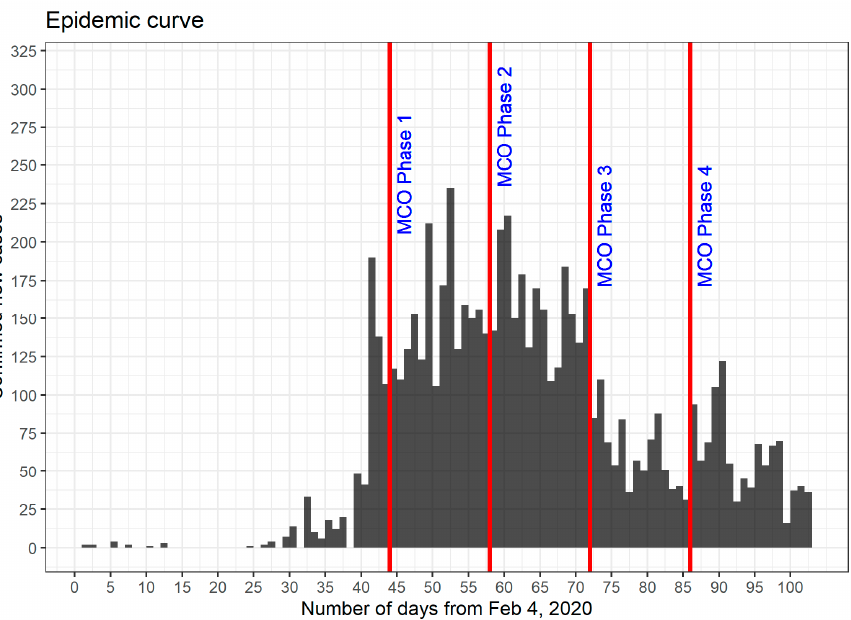
Figure 2. Epidemic curve between day 1 (4 February 2020) and day 102 (16 May 2020) for Malaysia.